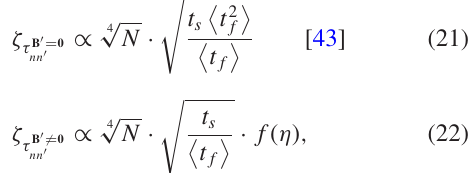
Figure 6. Decay in the magnitude of B 0 magnetic field when the current through the B 0 coil is turned off, as measured by the 199 Hg magnetometer. The line and the shaded region indicate an exponential decay fit and its 1 σ uncertainty,